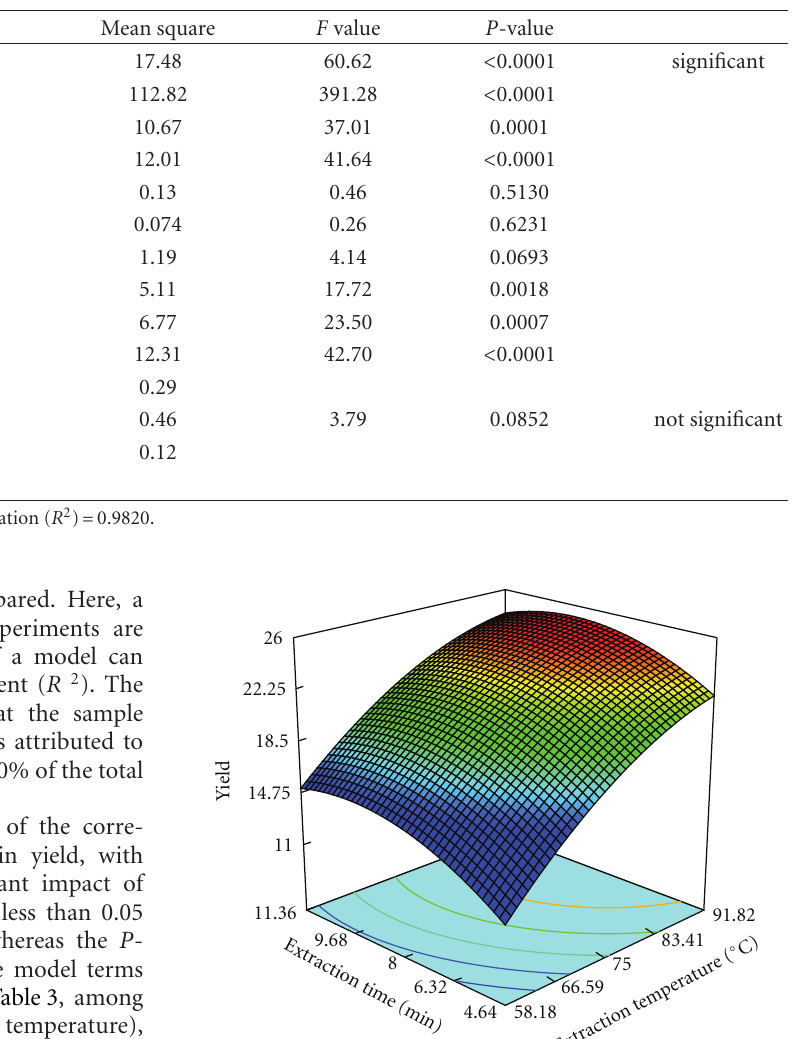
Table 3: Variance analysis of regression equation.